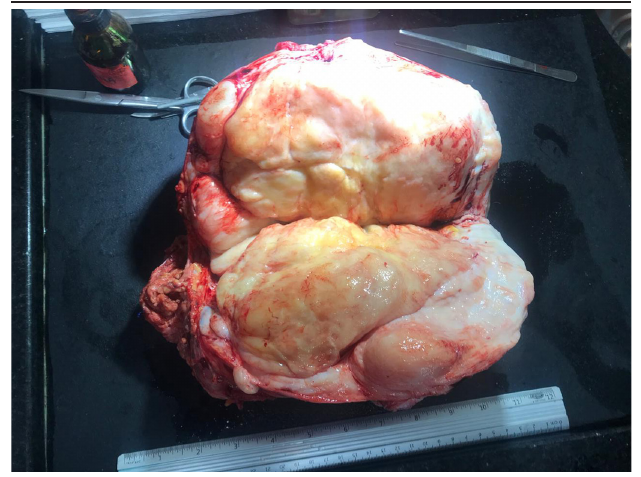
FIGURE 2 – Surgical resection of the tumoral lesion